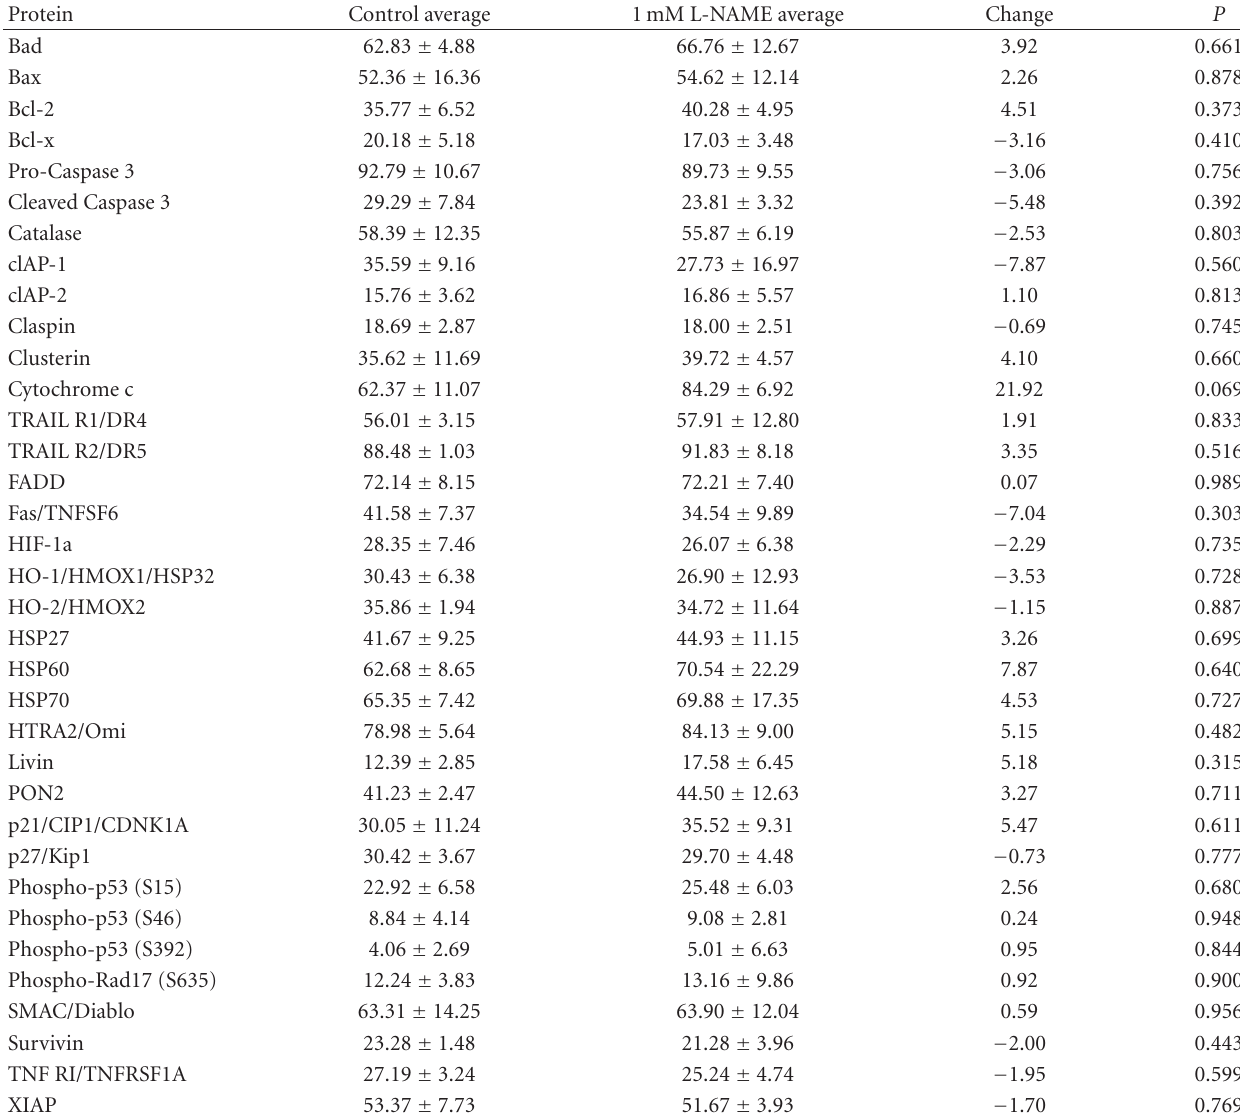
Table 3: Protein levels of 35 apoptosis-related proteins after treatment of HAECss with 1mM L-NAME.